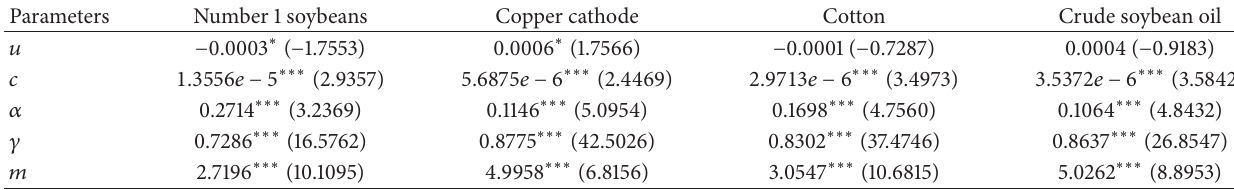
Table 3: Estimation of parameters of marginal distribution models.